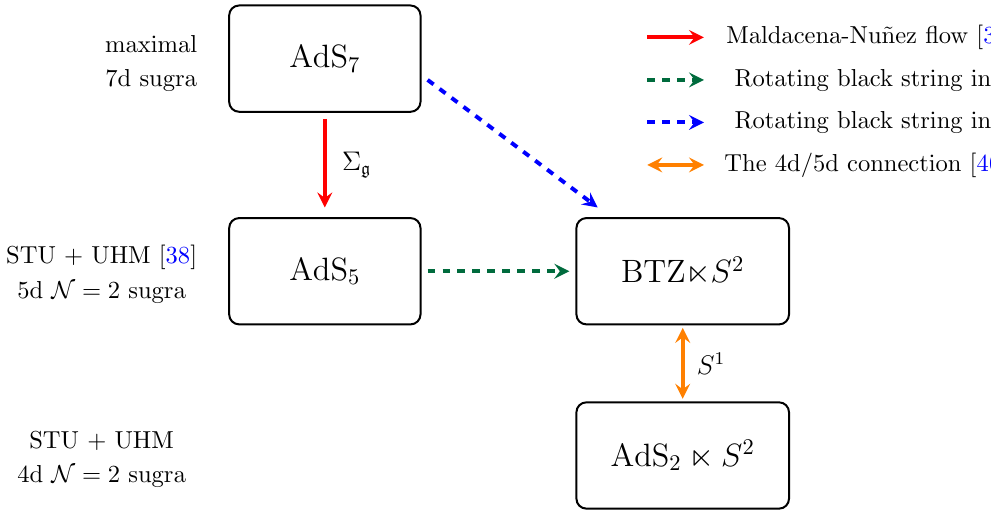
Figure 1 . Supersymmetric solutions in gauged supergravity and the (cid:13)ows that connect them. The direction of the one-sided arrows indicates the decrease of energy scale along the holographic RG